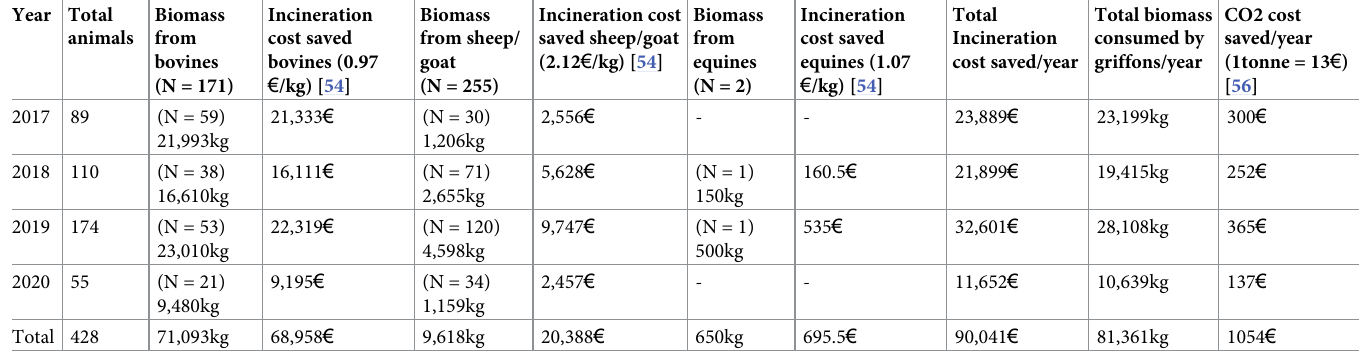
Table 2. Total number of animal cadavers from each animal species and corresponding biomass produced with the cost saved from incineration and carbon emis- sion in each